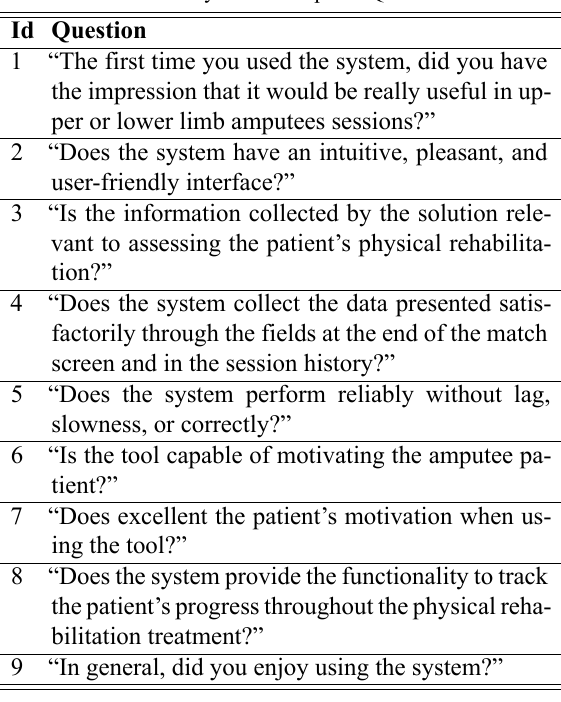
Table 4. Physical Therapist‘s Questions.